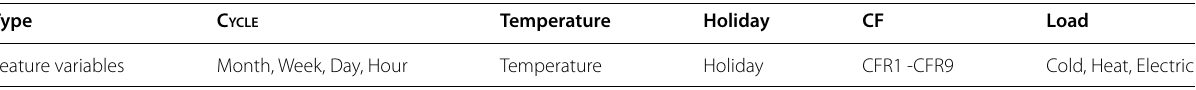
Table 1 Input variables of RIES load forecasting model Type